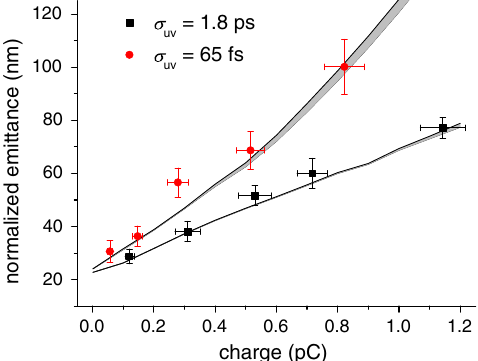
FIG. 7. Measured normalized emittance of beams when the UV laser was stretched to a 1.8 ps rms parabolic longitudinal profile (black square) and was ultrashort at 65 fs rms (red circle). The error bars indicate the statistics over 20 shots. Simulation results for both cases are also